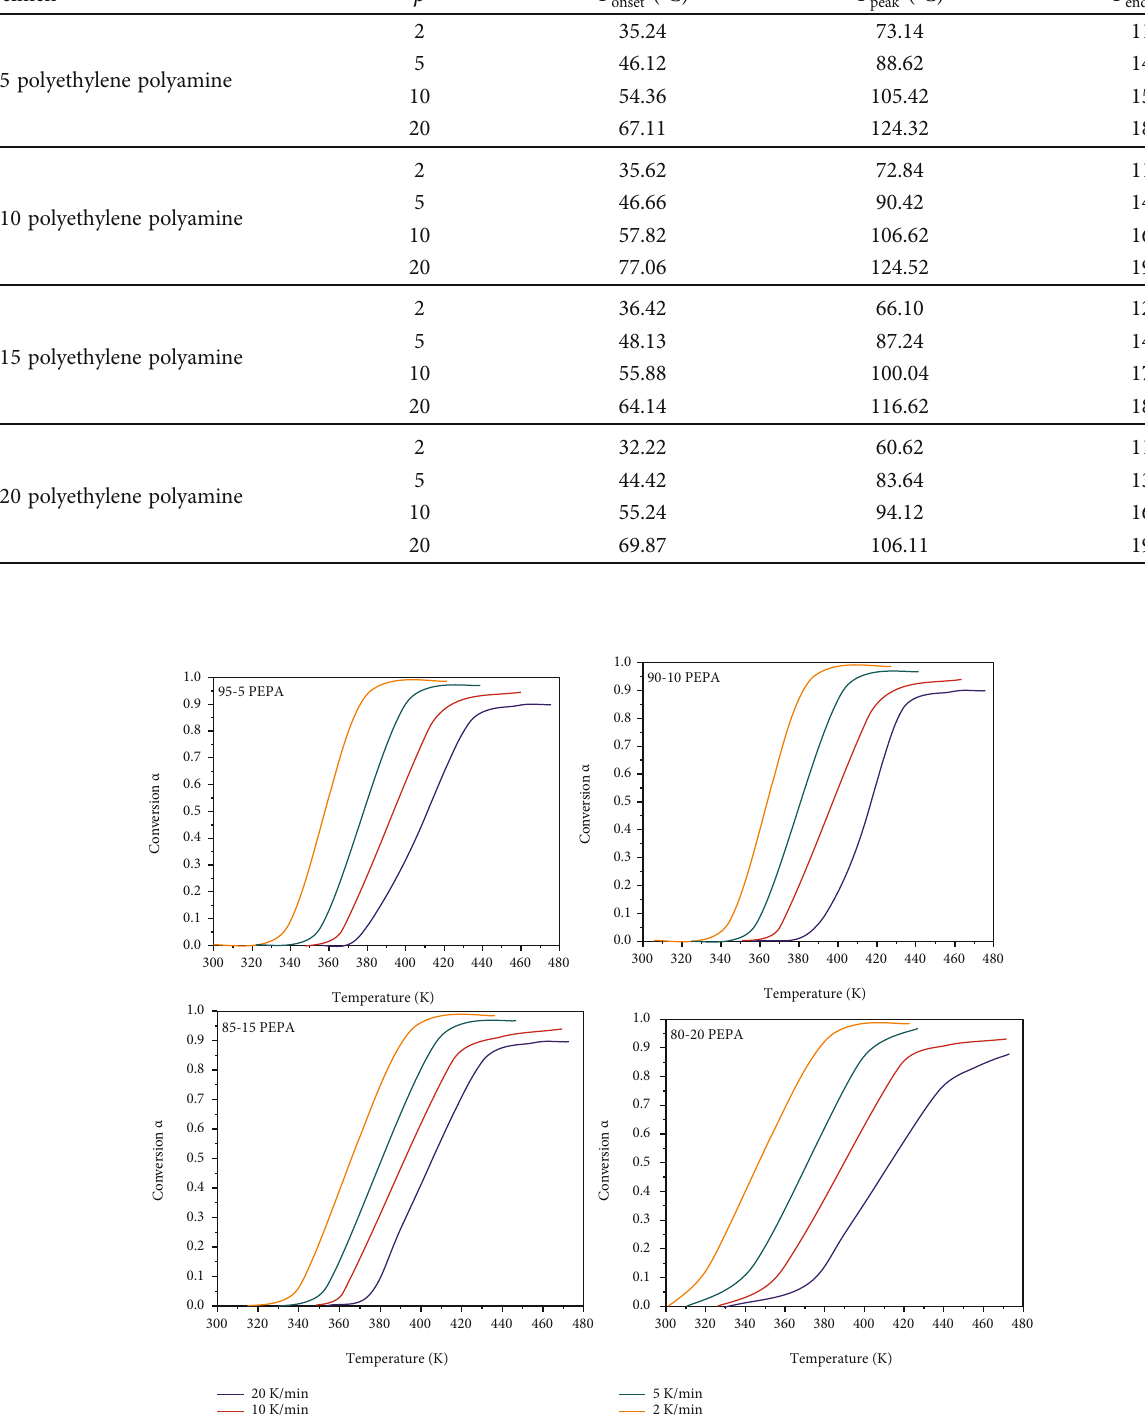
Table 2: Di ff erential scanning calorimetry curing parameters of polyethylene polyamine and systems. Specimen